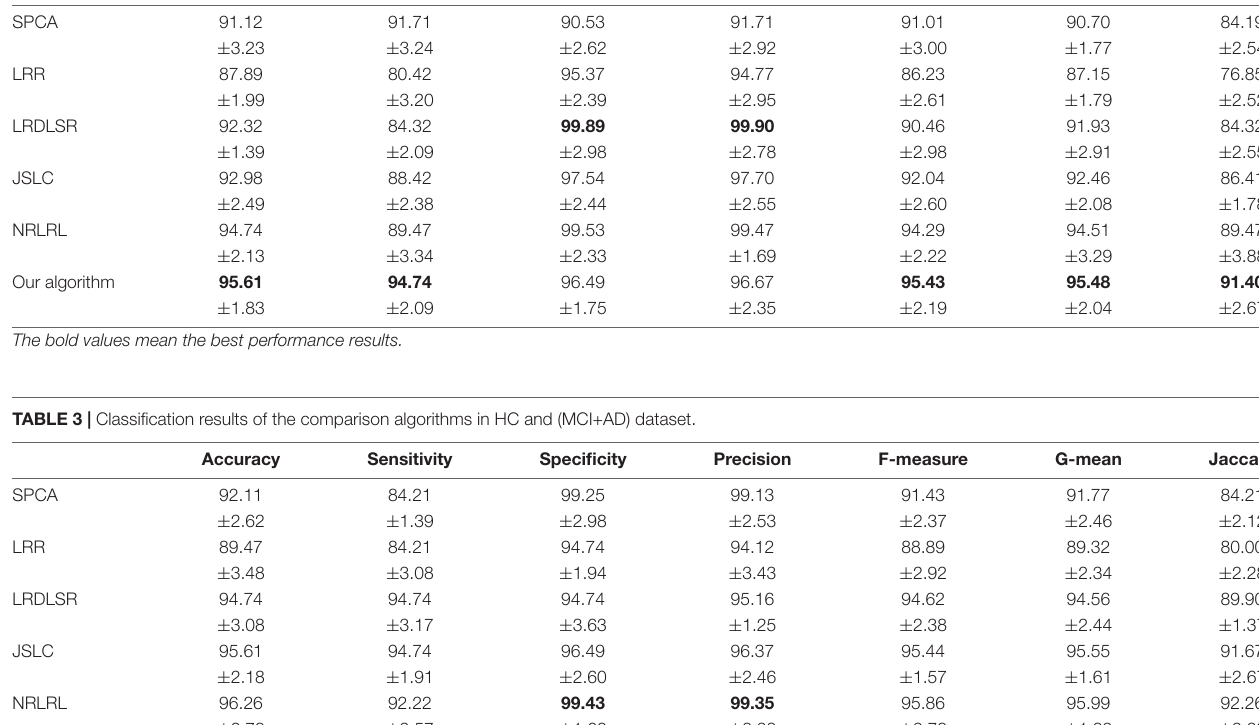
The bold values mean the best performance